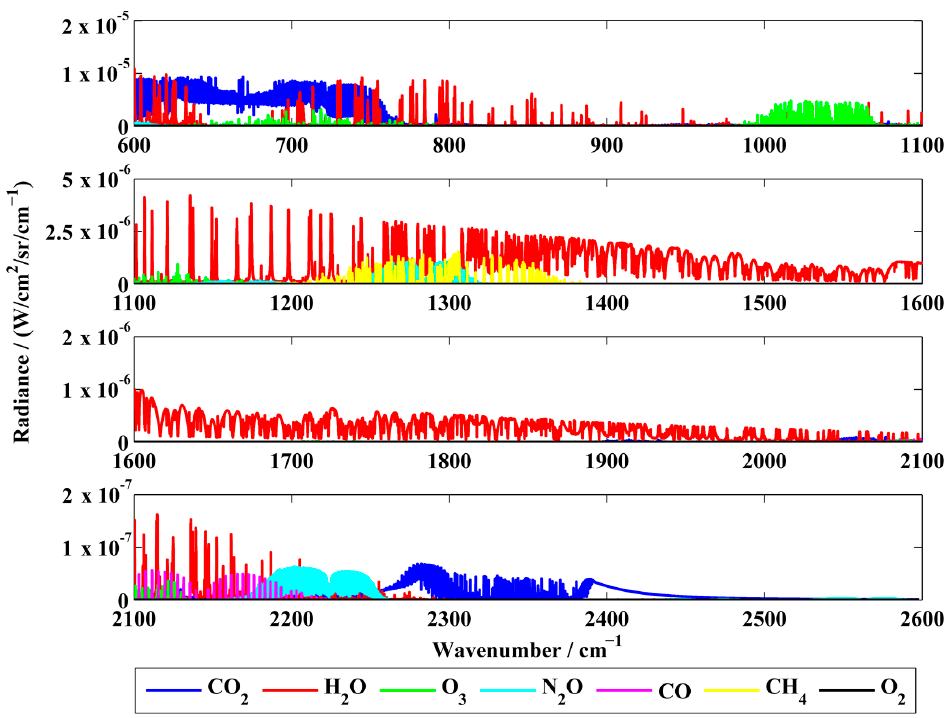
Figure 2. The emission spectra of the major atmospheric molecules. The calculation is performed by using the HITRAN 2020 database [39] and US Standard Atmosphere (1976 version).